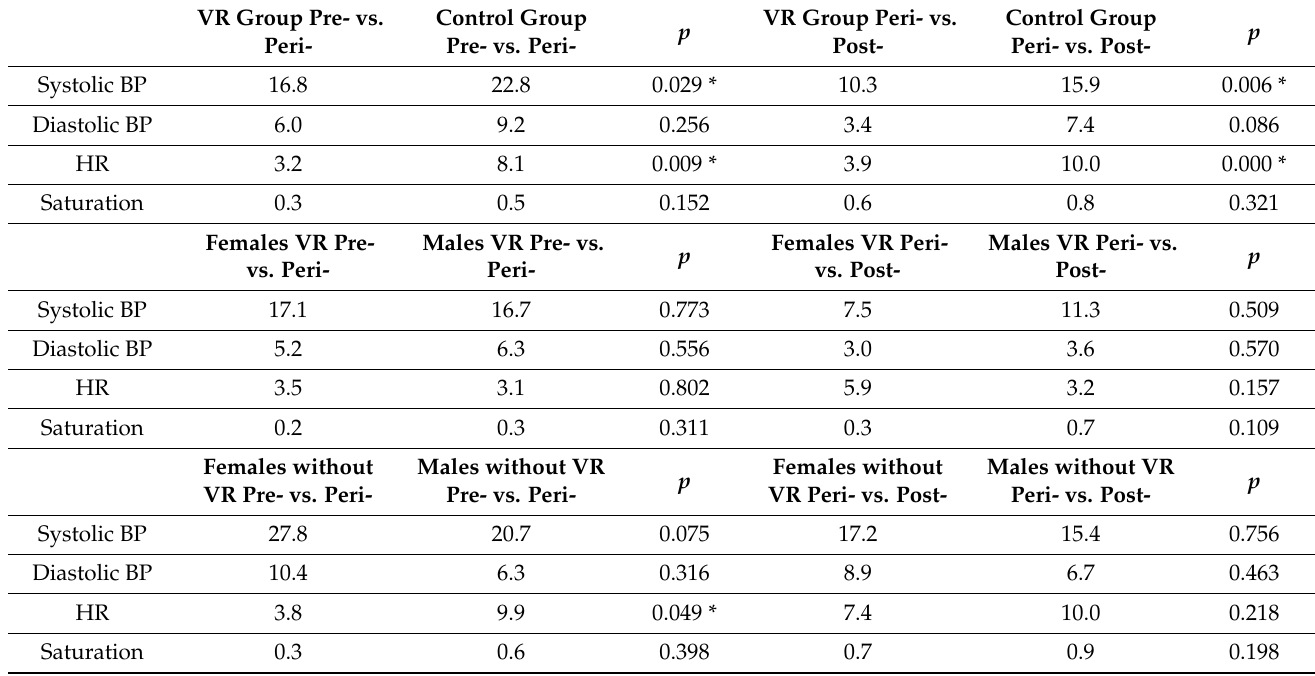
Table 4. The absolute differences between the mean values of each parameter measured at the given study timepoint. VR Group Pre- vs.